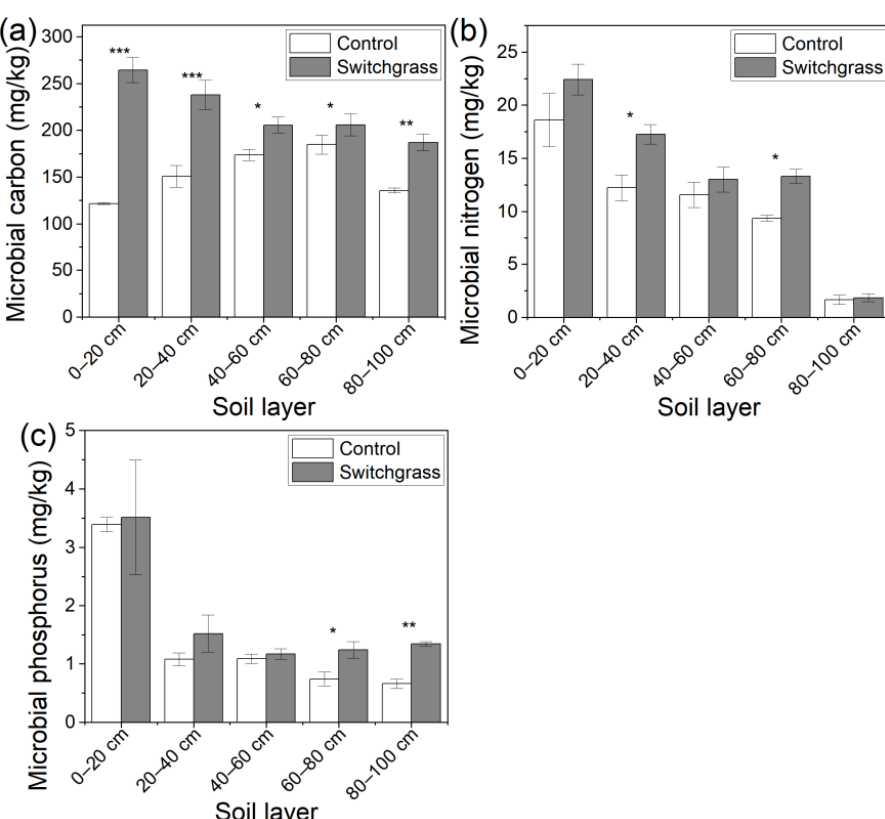
Figure 5. Soil microbial ( a ) carbon, ( b ) nitrogen, and ( c ) phosphorus contents in bare land and switchgrass-cultivated land. Error bars (standard deviation) were correctly added at the top of the mean columns. A Wilcoxon rank-sum test was used to analyze the significant differences between the bare land and switchgrass cultivated land at p < 0.05 (*), 0.01 (**), and 0.001 (***) levels. According to the heatmap results, the microbial indicators, including the CFU numbers of the bacteria, fungi, and actinomycetes as well as MC, MN, and MP contents, were all positively correlated with WSOC, TP, SOC, TN, and AN (Figure 6). The microbial indicators (excluding MC) were negatively correlated with soil pH, TK, and AK. Soil AK showed significantly ( p < 0.05 or 0.01) negative correlations with the CFU numbers of three microbial communities and MN (Figure 6). Soil pH, as an important soil indicator, was also included into the correlation analysis although few differences were observed in this study (the data was not shown). Soil MN exhibited significantly ( p < 0.01) negative correlations with soil pH, TK, and AK (Figure 6). Soil MC only had significant ( p < 0.01) positive correlations with soil TPO (Figure